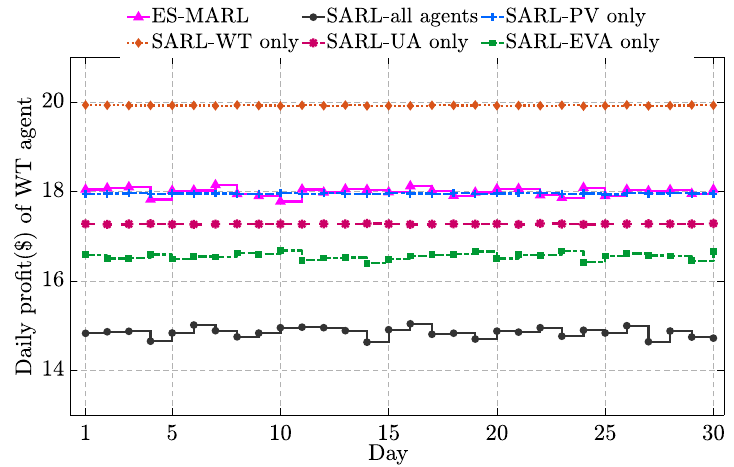
Figure 6. WT agent’s daily profit in different RL